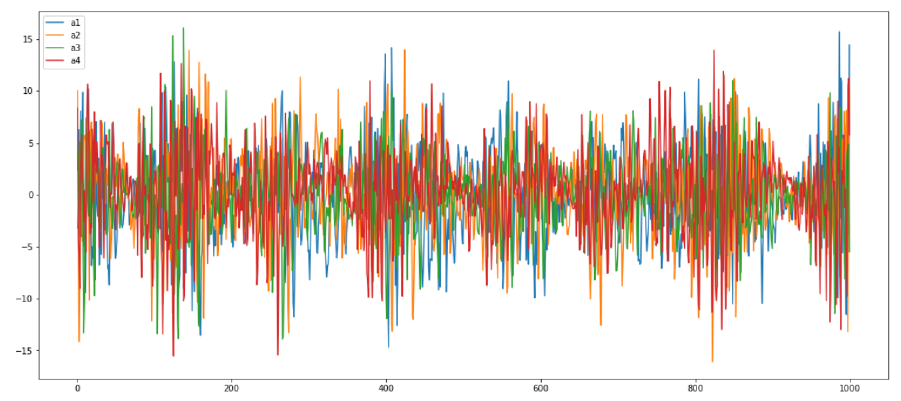
Figure 5. Time-domain analysis of all sensors a 1 , a 2 , a 3 , a 4 .